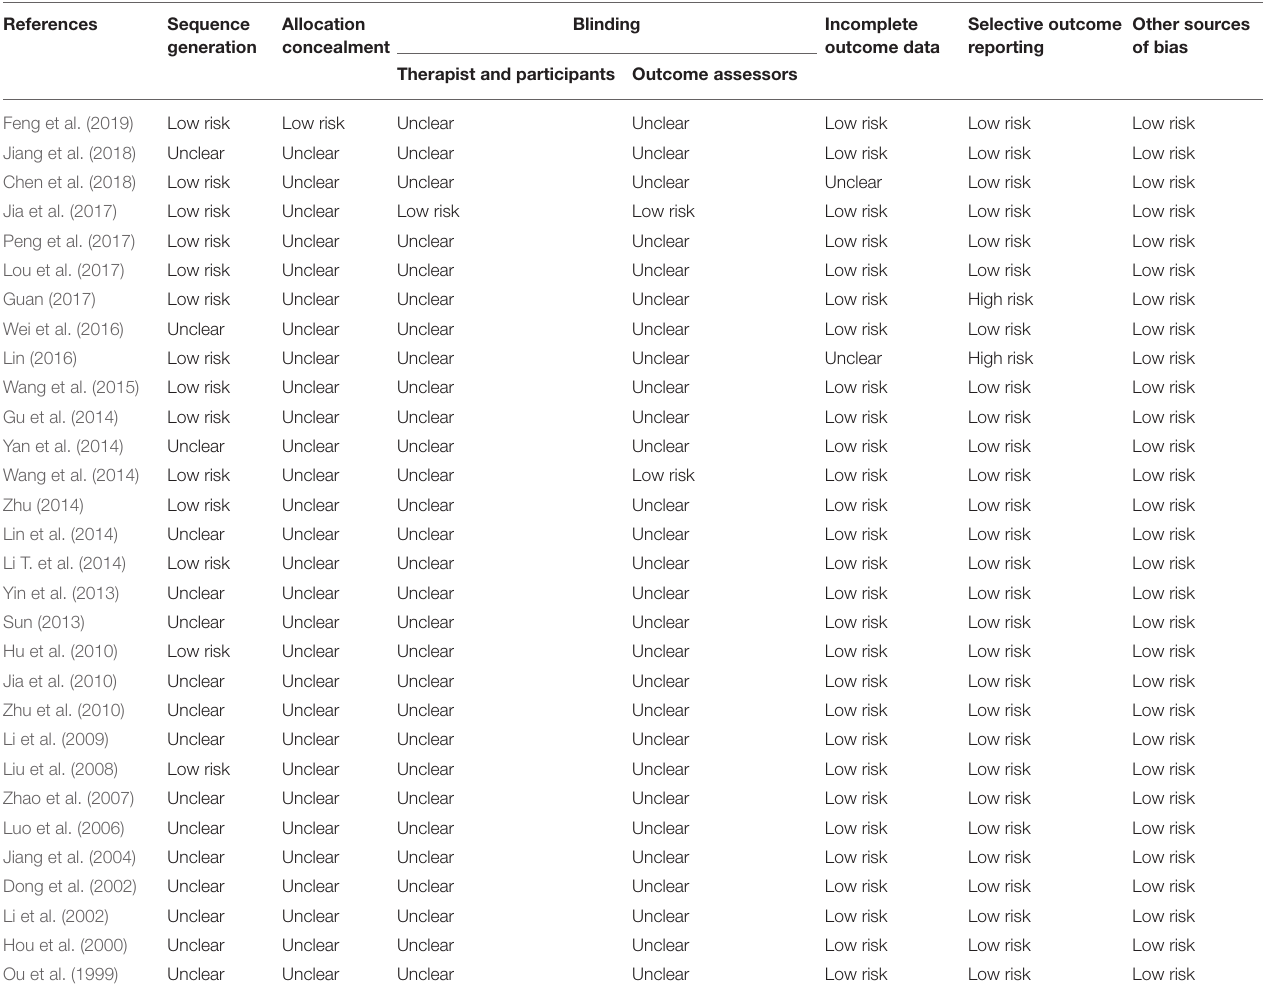
TABLE 2 | Quality assessment of methodology of included